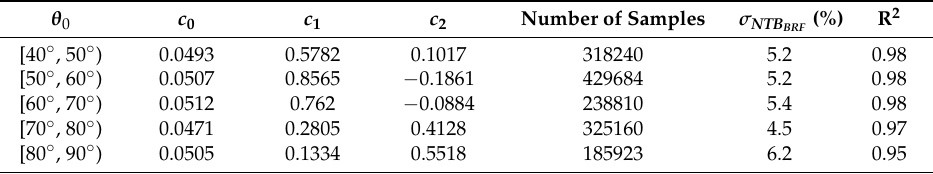
Table 3. Coefficients c 0 , c 1 , and c 2 for conversion of the Multi-angle Imaging SpectroRadiometer (MISR) Red and Near Infrared (NIR) spectral Bidirectional Reflectance Factors (BRFs) to broadband BRF for collocated Clouds and the Earth’s Radiant Energy System (CERES) overcast ocean scenes, as well as the corresponding relative root-mean-square (RMS) differences ( σ NTB determination (R 2